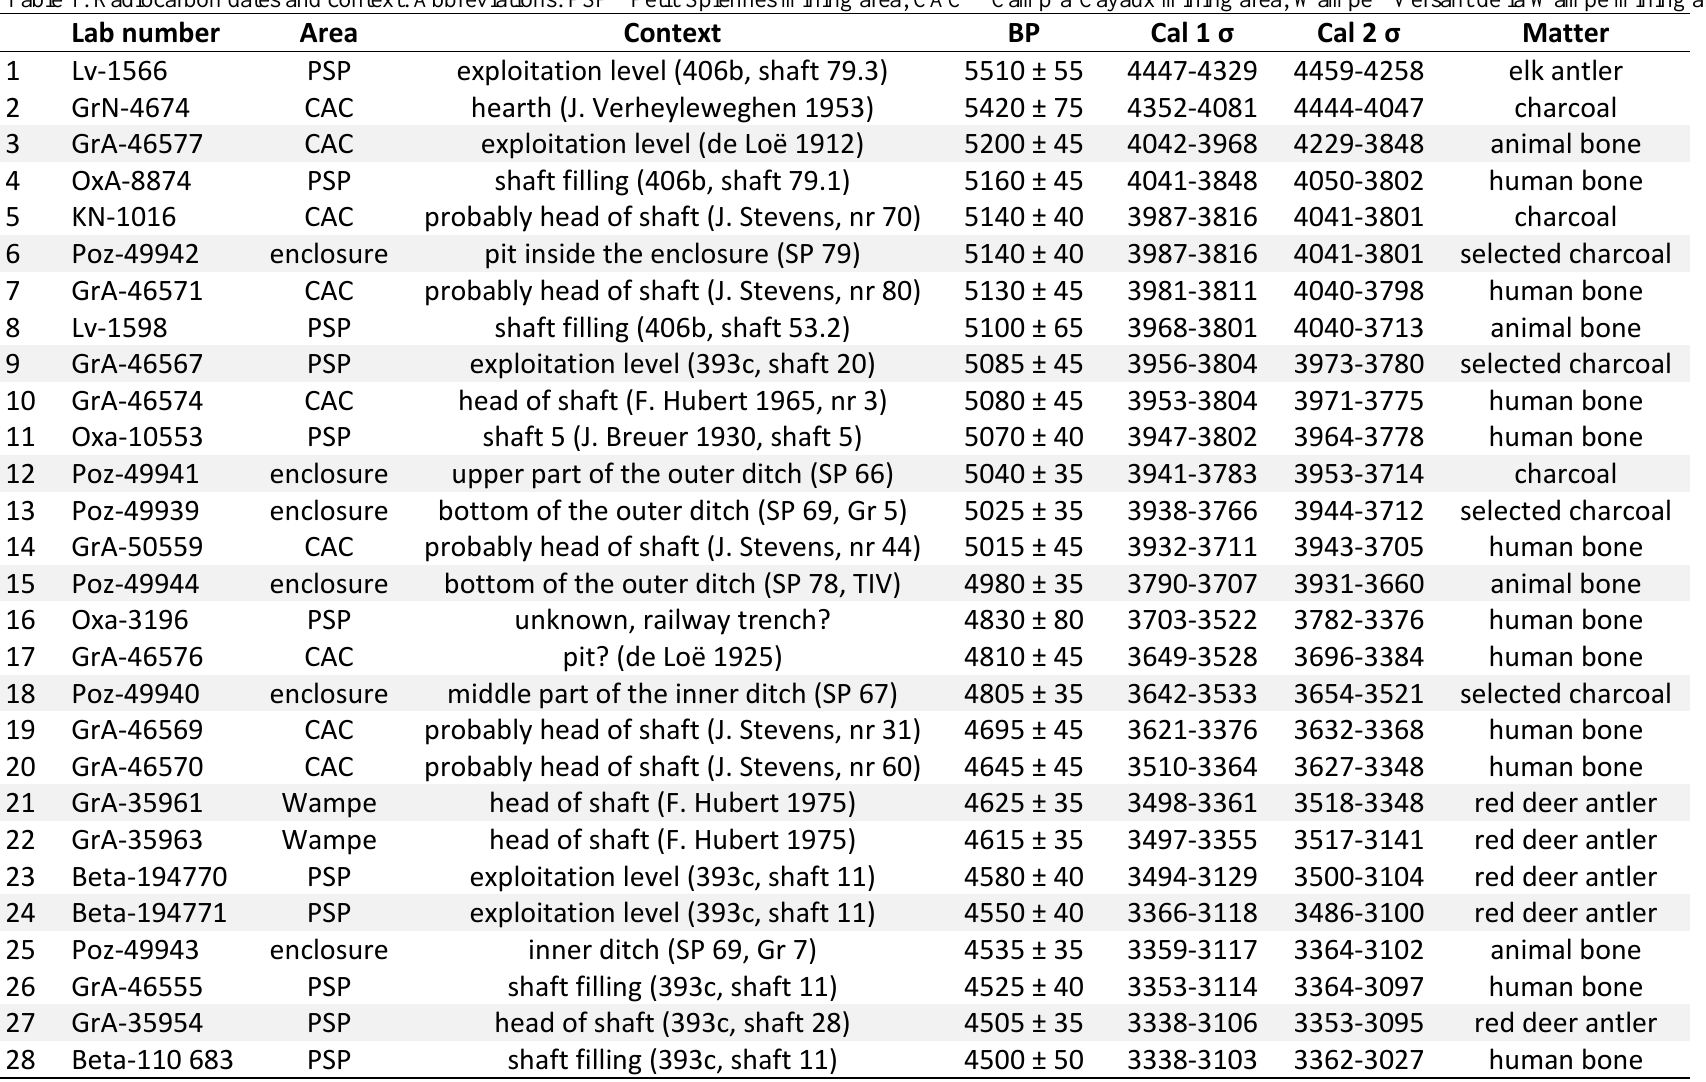
Table 1. Radiocarbon dates and context. Abbreviations: PSP - Petit-Spiennes mining area; CAC - Camp-à-Cayaux mining area; Wampe - Versant de la Wampe mining